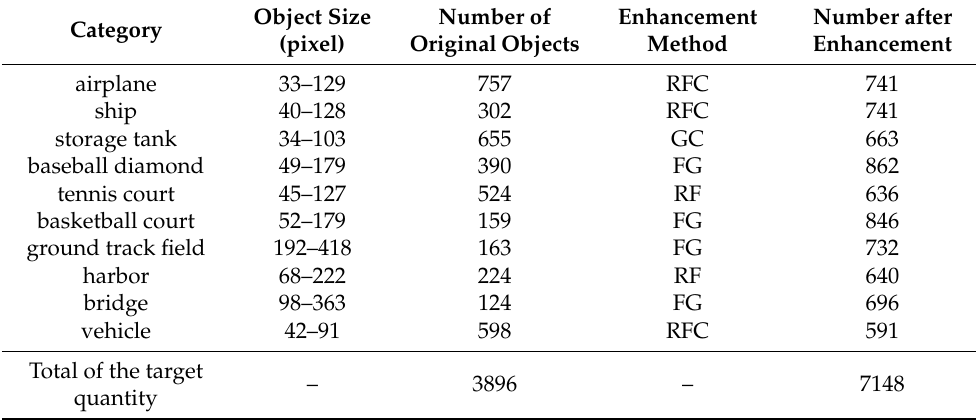
Table 1. Target number table of datasets before and after